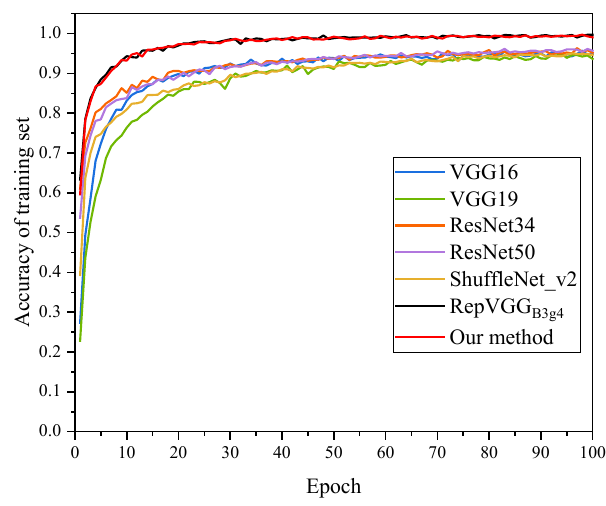
Figure 10. Comparison of the accuracy of each method training set.